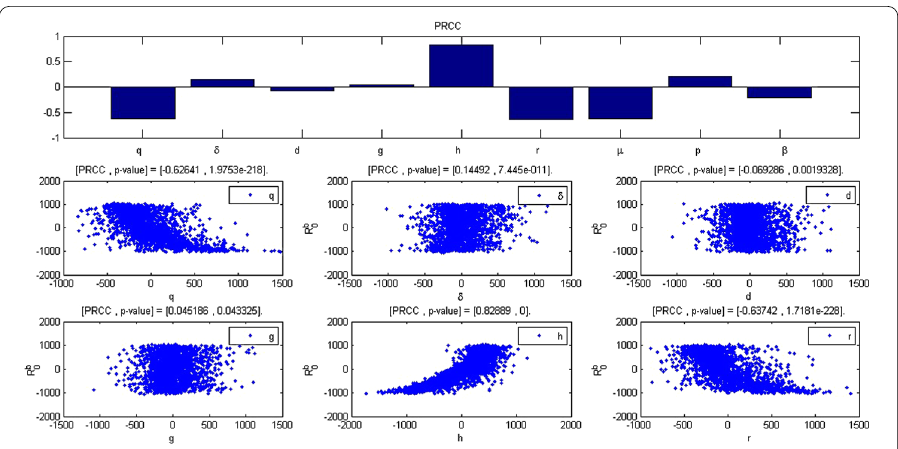
Figure 5 The scatter PRCC value of the threshold R p 0 to key parameters and the scatter plots of the parameters q , δ , d , g , h , r . The sample size is 2000 and all parameters are varied simultaneously. The parameter values are as follows: q = 20, δ = 0.6, d = 0.4, g = 0.05, h = 0.1, r = 0.8, μ = 0.4, p = 20 and β =